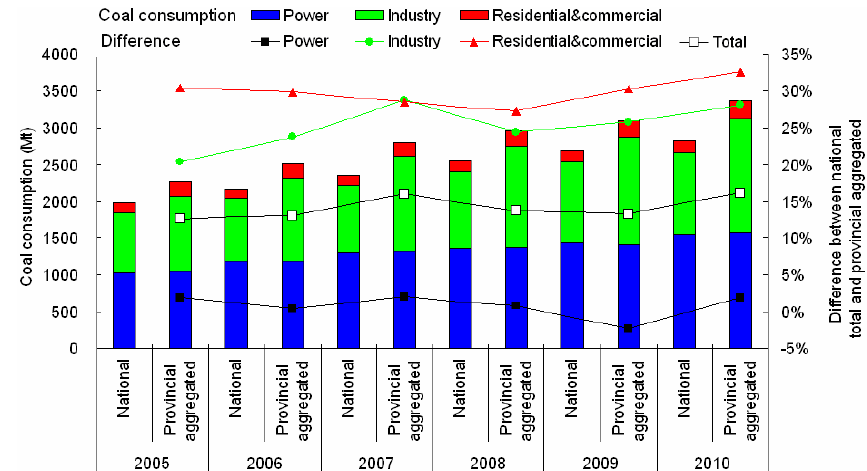
Fig. 1. China’s coal consumption by sector and the relative difference between the national total statistics and aggregation of provincial statistics from 2005 to